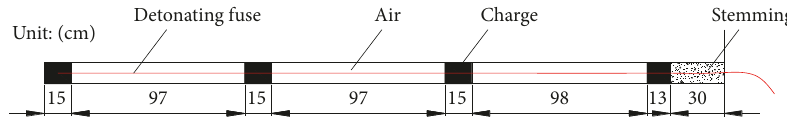
Figure 14: Optimized charging structure of peripheral hole in Grade III surrounding rock.